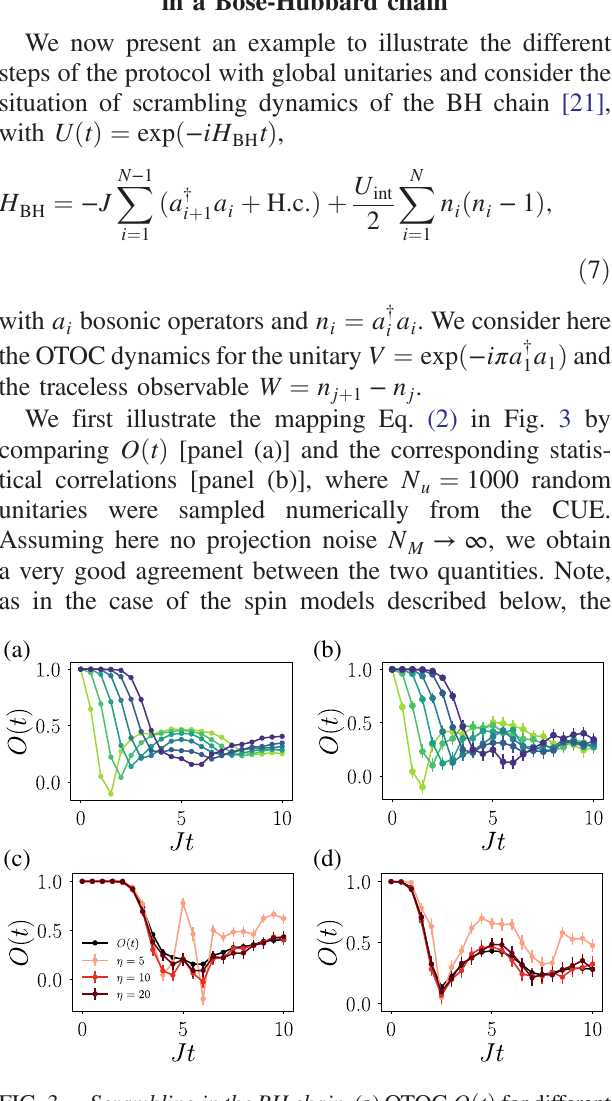
FIG. 3. Scrambling in the BH chain . (a) OTOC O ð t Þ for different positions j ¼ 2 ; … ; N − 1 (green to purple) of the operator W (see text). (b) O ð t Þ estimated with N u ¼ 1000 unitaries u sampled numerically from the Haar measure. (c,d) Comparison between O ð t Þ and corresponding estimations via statistical correlations, where u is prepared via η random quenches, with j ¼ 7 (c) m Þ and j ¼ 4 (d), and N u ¼ 1000 . Here, Δ ð j is sampled from a uniform distribution of width 2 J , and the quench time is T ¼ 1 =J . For all panels, we consider N ¼ 8 lattice sites with j k 0 i ¼ j 10101010 i in the number basis, and U int ¼ 2 J . In panels (b) – (d), error bars at 2 standard deviations are calculated using the jackknife resampling method. Here, we consider N M → ∞